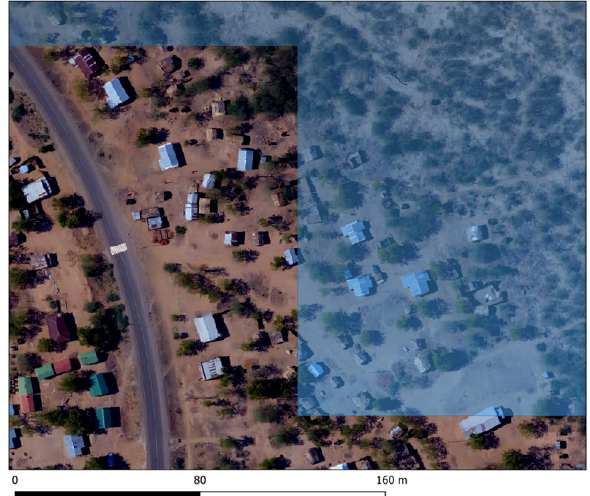
Figure 11. pre-event UAV orthophoto of Bangula (COOPI 2018); superimposed the flood extent of march 2019 (Netherlands Red